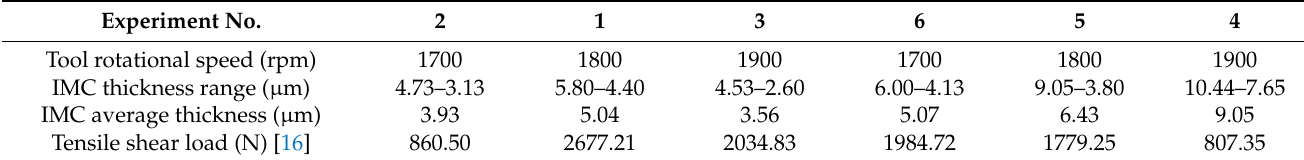
Table 4. IMC thickness range and thickness average and TSL on TRS.